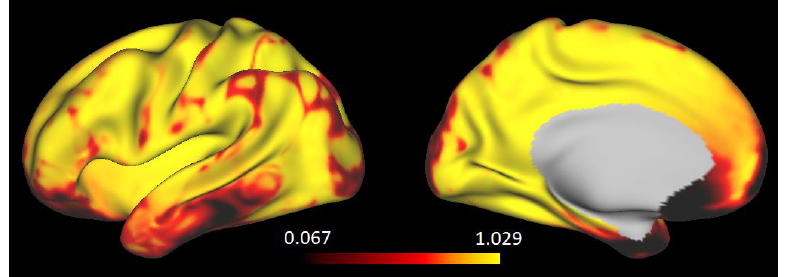
Figure A2. Map characterizing magnetic field inhomogeneities in the human brain. Data obtained from the phase information of the qGRE signal by means of the voxel spread function approach [25]. The yellow color designates areas lightly affected by magnetic field inhomogeneities. The black color designates severely affected areas. The scale bar shows values of the F-function at the gradient echo time TE = 40 ms. The F-function shows a fraction of the signal not affected by the loss due to the field inhomogeneities, ranging from 1 (no signal loss) to 0 (full loss of signal). Images show a significant loss of the signal in both limbic networks, thus adversely affecting the quantitative analysis of both rs-fMRI and qGRE data.